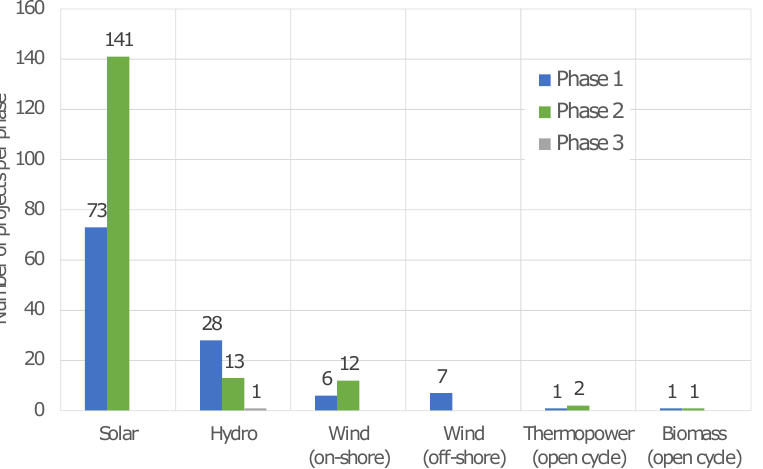
Figure 3. NCRES planned projects in stages of prefeasibility (phase 1), feasibility (phase 2), and detailed engineering (phase 3) with expected operation from 2023 in Colombia. Built with data from [39].